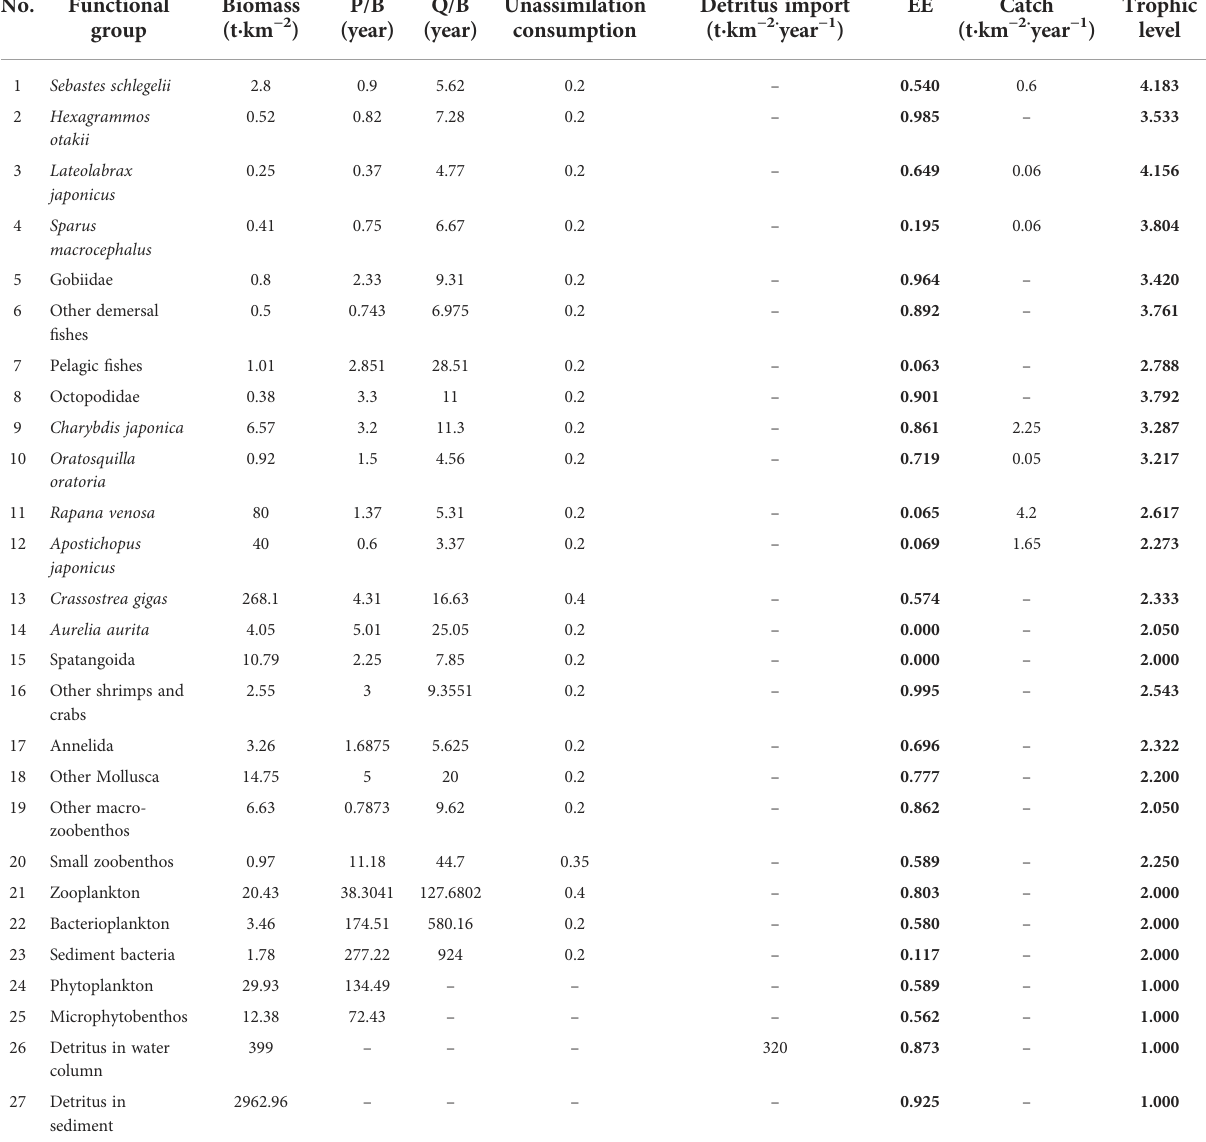
TABLE 4 Summary of the input and output parameters for functional groups as estimated by the EwE model of Laizhou Bay stocking marine ranching ecosystem.